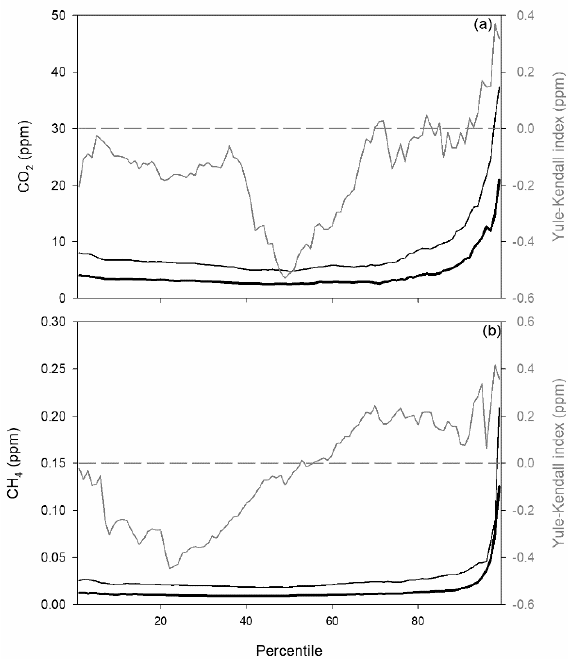
Figure 5. Parameters of the linear fit of monthly percentiles. Vertical lines indicate that correlations below these percentiles are statistically significant at a 0.001 level. ( a ) CO 2 , ( b ) CH 4 . Monthly percentiles were detrended, and robust statistics of residuals (i.e. , differences from the